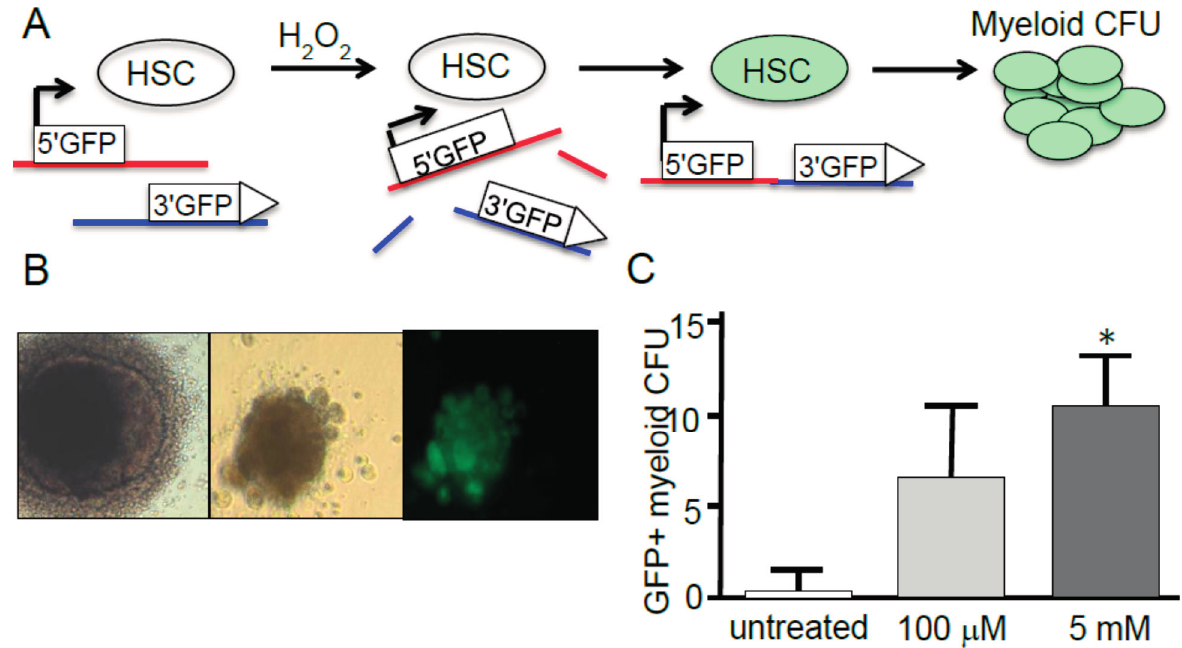
Figure 2. Direct connection between exposure of hematopoietic stem cells (HSC) to reactive oxygen species (ROS) and genome rearrangements. ( A ) Scheme of exposure of genetically engineered HSC to ROS and scoring of GFP+ cells indicative of translocations; ( B ) Left image—HSC colony by contrast microscopy (100×); Middle image—GFP+ derivative myeloid CFU (colony-forming units) by contrast microscopy (100×); Right image—Same GFP+ CFU colony shown in middle by fluorescence microscopy (100×); and ( C ) Bar graph showing dose dependent appearance of GFP+ myeloid CFU derived from HSC exposed to 0, 100 μ M, or 5 mM H 2 O 2 for 30 min, then returned to normal conditions. 100 μ M resulted in an average frequency of CFU at 6.5 × 10 − 6 ; 5 mM resulted in an average frequency of CFU at 10.4 × 10 − 6 . * denotes statistically significant stimulation of chromosomal translocations by H 2 O 2 (students t -test p -value < 0.037). A few colonies were observed in untreated samples that by contrast microscopy but appeared to be unviable and auto-fluorescent rather than bona fide GFP+ CFU; however, further analysis was not performed on them so they are reported